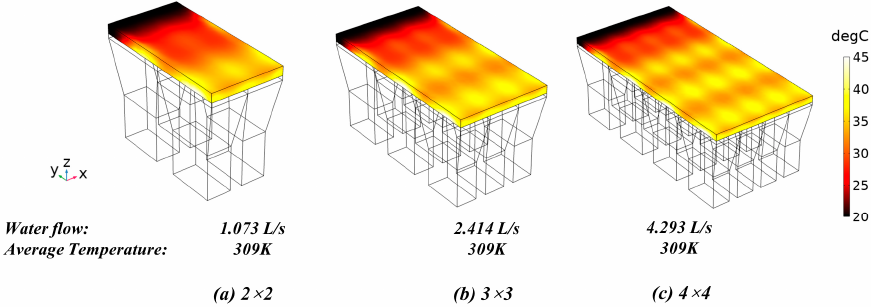
Figure 17. Diagram of scale-up.